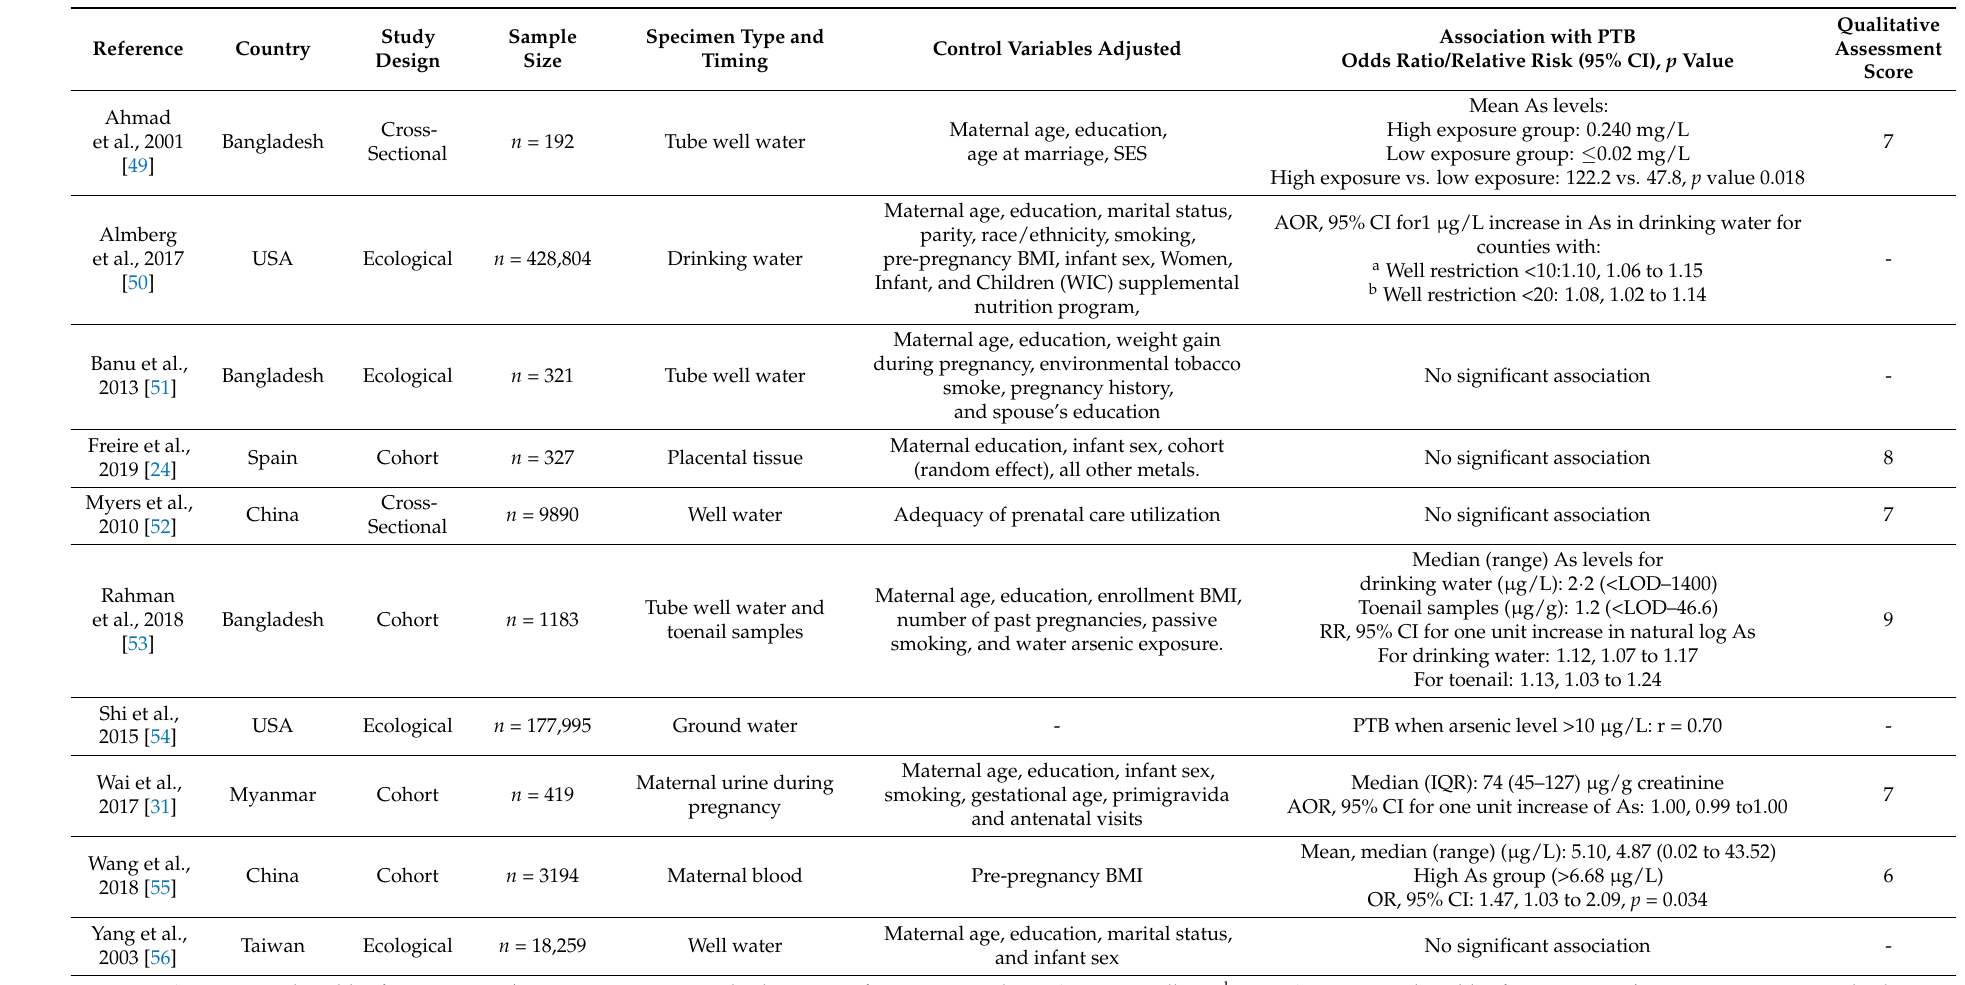
Table 4. Association between Arsenic and